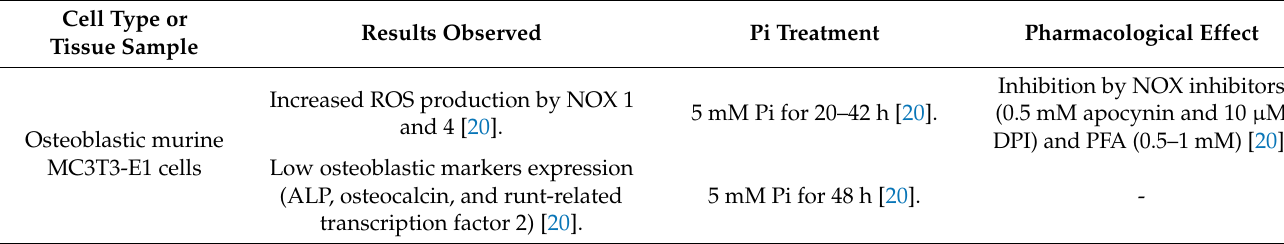
Figure 1. Phosphate-induced osteoblast apoptosis mediated by ROS production. In the localized remodelling area, when osteoblasts are exposed to Pi levels substantially more significant than those typically found in serum, osteoblasts initiate apoptotic pathways by uncontrolled ALP activity. Sodium-dependent Pi transporters internalize Pi. Pi promotes a hyperpolarization of the mitochondrial membrane potential ( ∆Ψ m) until 2 h and induces ROS production. ROS can activate caspases. Ca 2+ can be internalized by Ca 2+ channels (although this calcium channel has little effect on Pi-induced osteoblast apoptosis signalling). High intracellular Ca 2+ is observed after 4 h by Pi treatment, and Ca 2+ may influence Pi-mediated bone cell apoptosis [19,22–24]. Solid black arrows indicate activation, and dashed black arrows indicate possible activation. Table 2. Pi-induced ROS production in osteoblasts